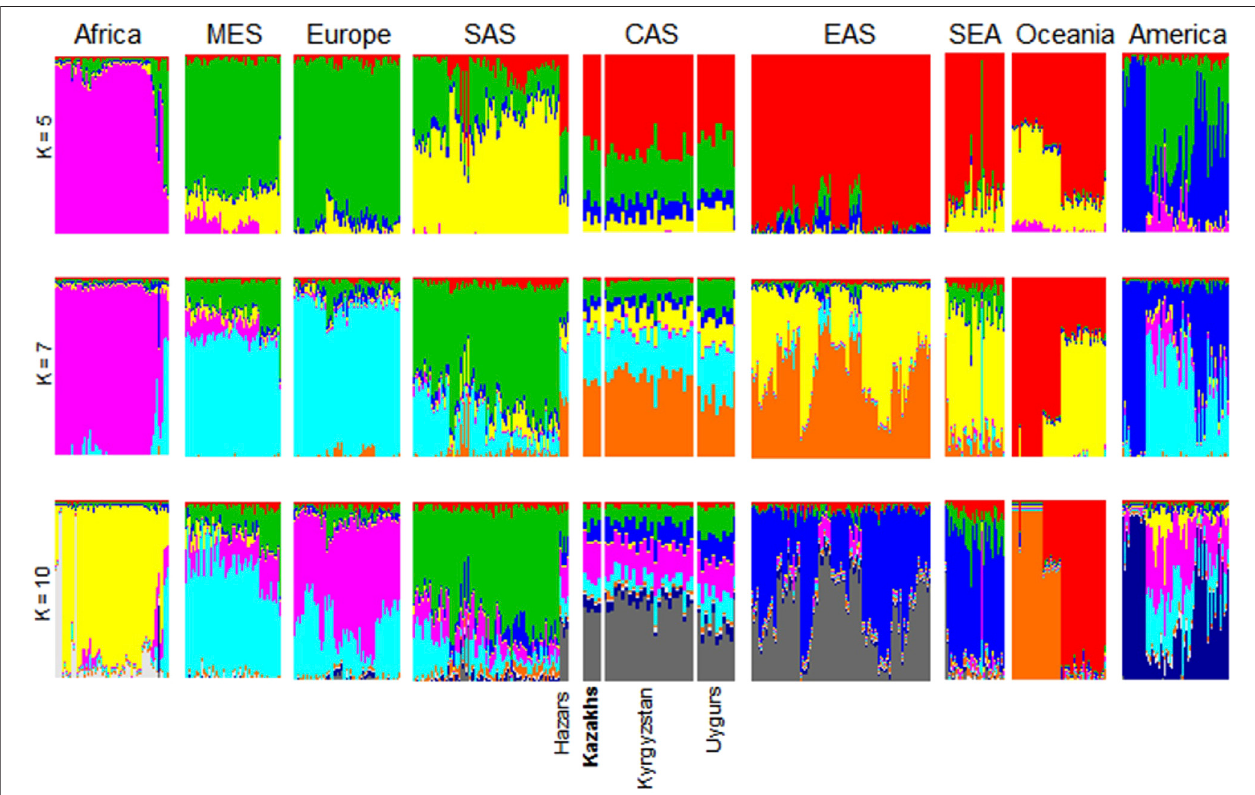
FIGURE 2 | ADMIXTURE plots for Kazakhs assuming a different number of ancestral populations. These fi gures were generated using genomic data from 3,805 individuals collected from the 1000G, HGDP, and Jorde genomic projects. ADMIXTURE analysis assumed ancestral populations (k) tobe 5, 7, or 10. The samples were clustered according to their geographical location to represent their genetic structure. Particularly, Central Asians (i.e., Hazars, Kazakhs, Kyrgyzstan, and Uygurs) had comparable levels of genetic admixture when varying Ks were assumed. AFR-Africa, AMR-America, CAS — Central Asia, EAS-East Asia, EUR-Europe, MES — Middle East, and SAS-South